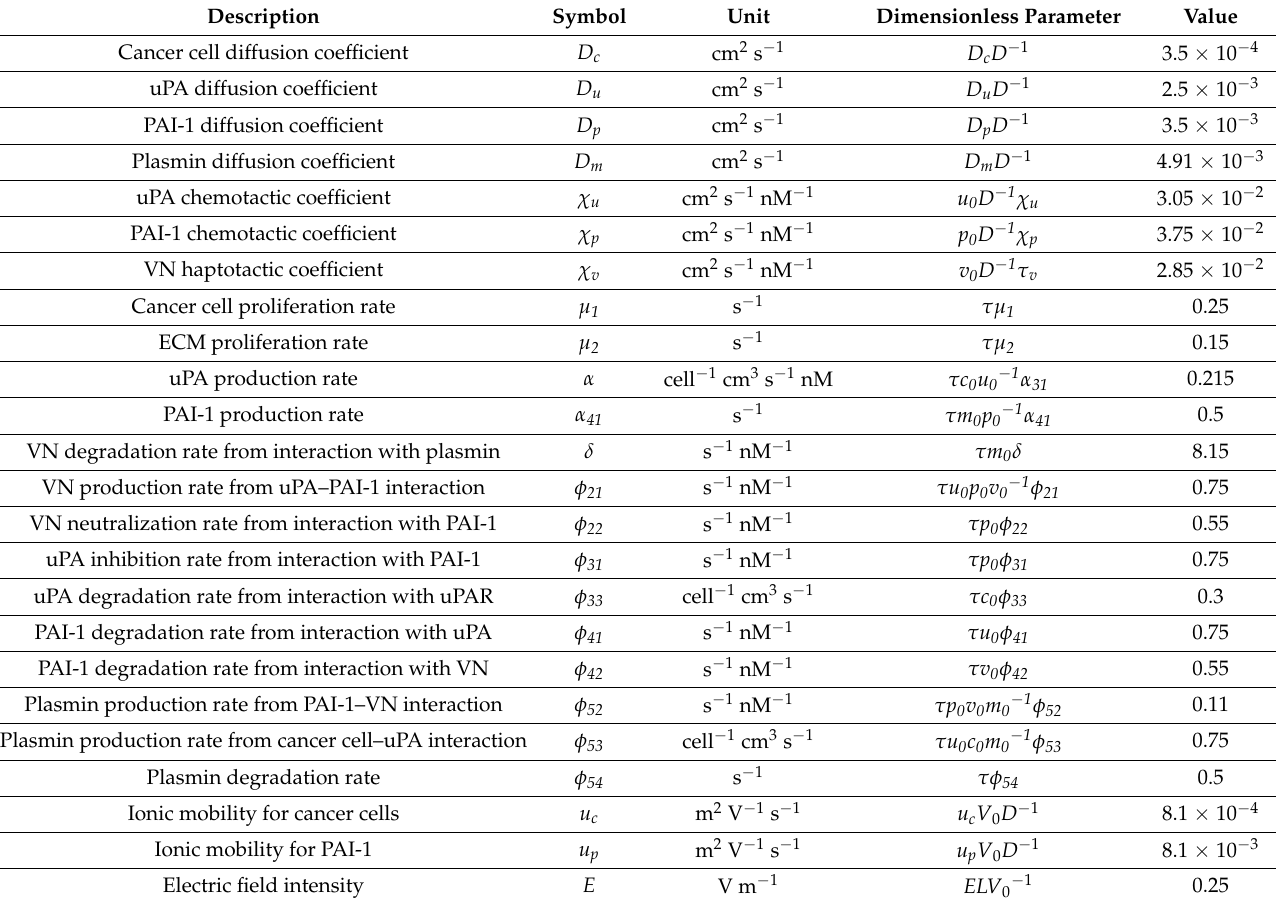
Table 1. Model parameter values used in the simulations. The fourth column shows the procedure used to nondimensional- ize the parameters. For reference values, please see